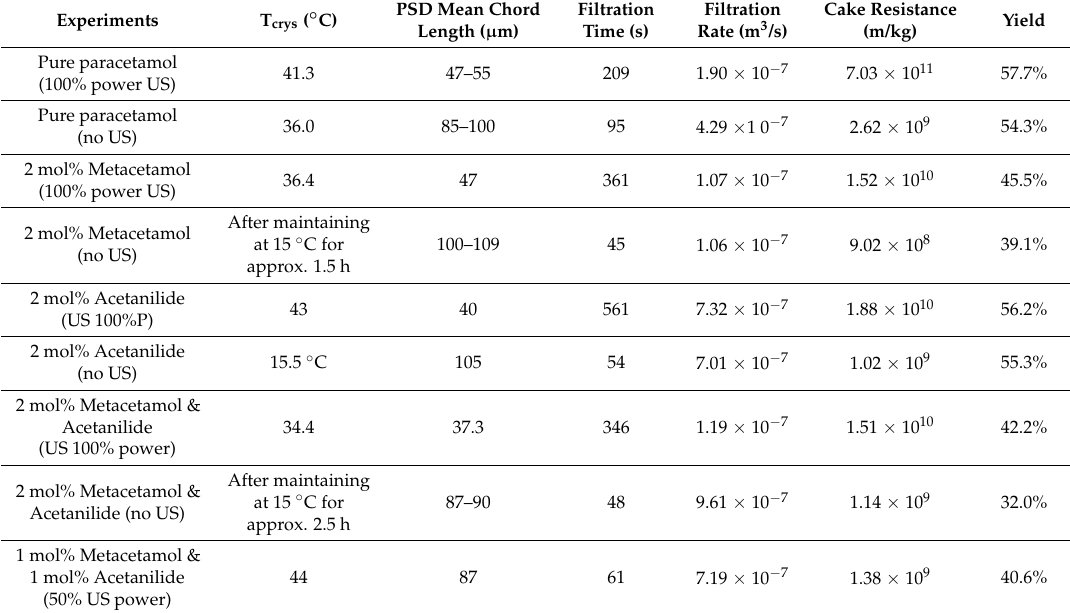
Table 3. Summary of crystallisation temperature, crystal size distribution, filtration time (for 50 mL suspension solution), filtration rate, cake resistance and process yield as a function of the percentage of impurities and ultrasonic